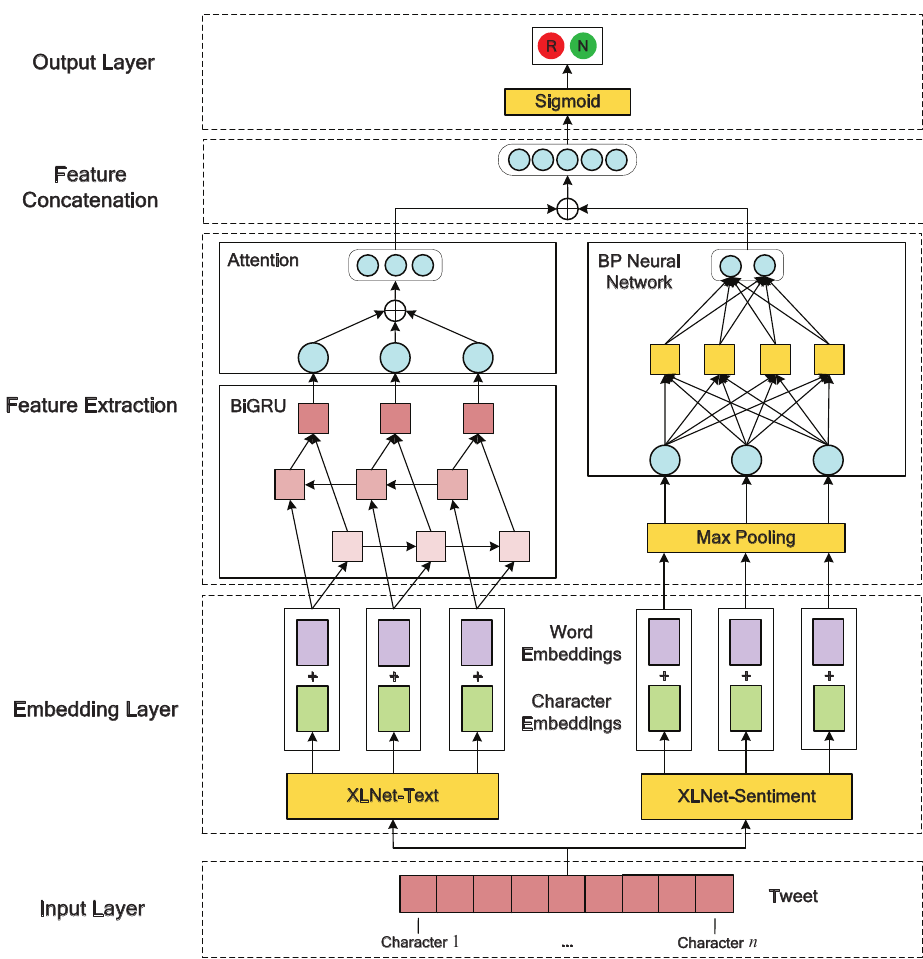
Figure 1. Structure of the XLNet-based BiGRU network with Attention mechanism (XGA)